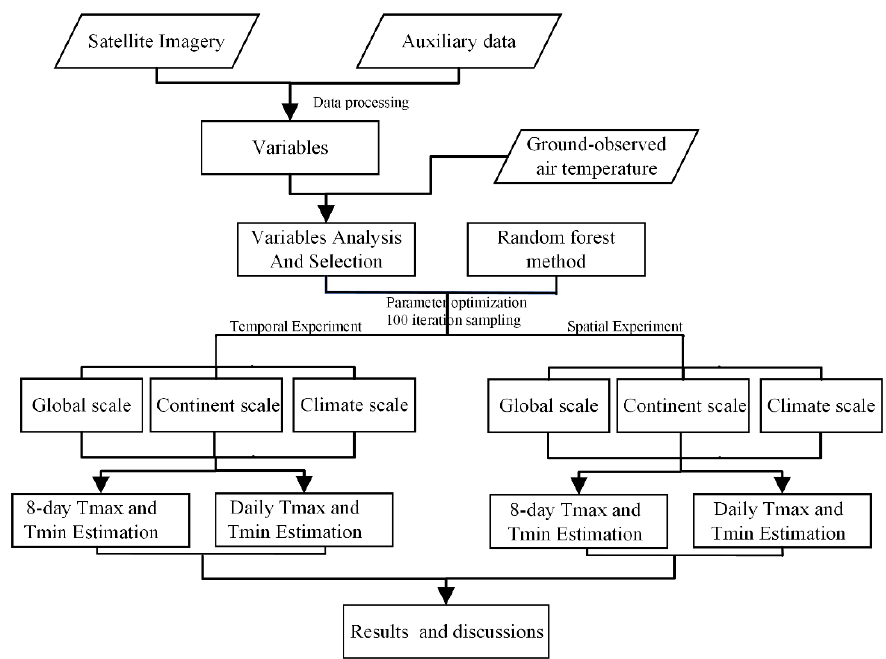
Figure 2. The framework design of this study.